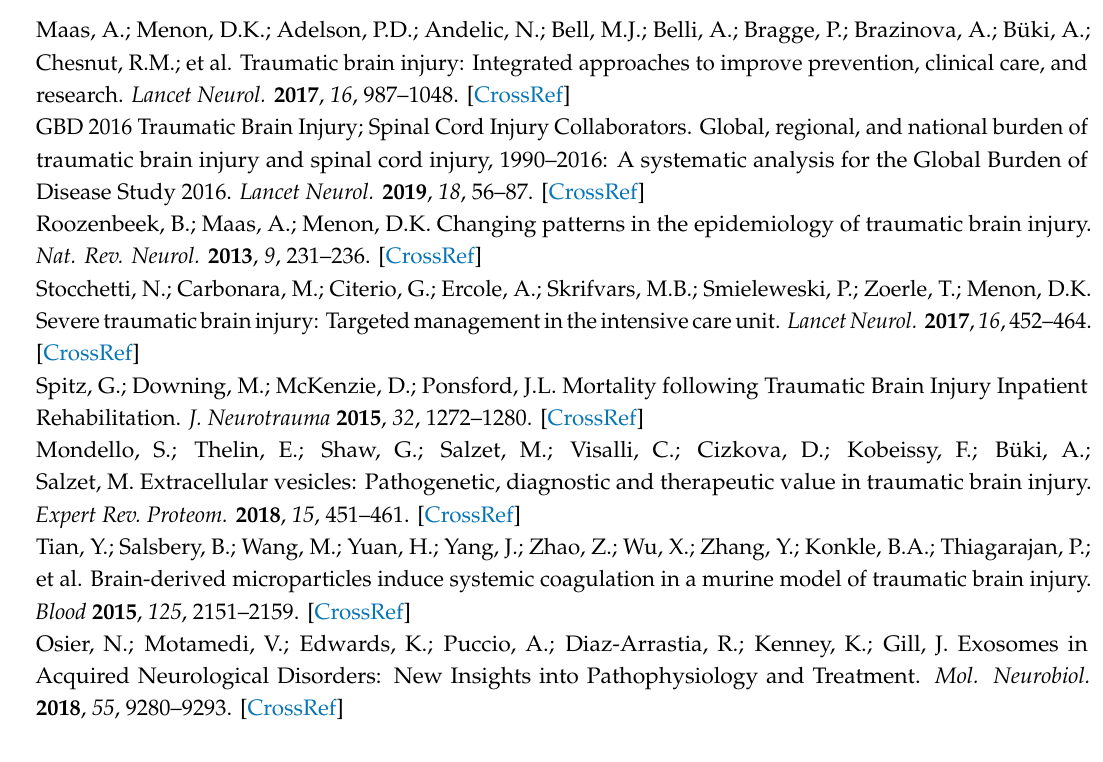
Figure S1: Biomarker time course profile in individual TBI